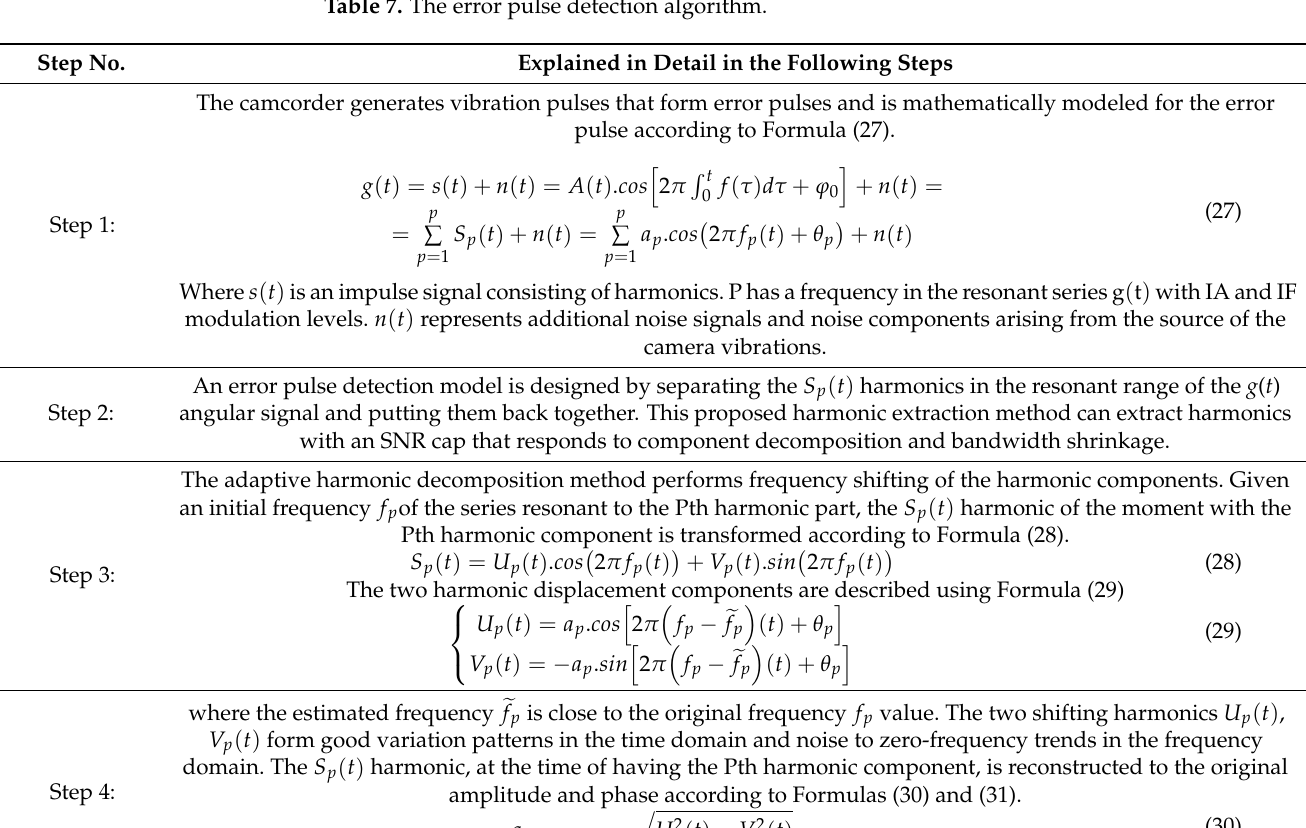
Table 7. The error pulse detection